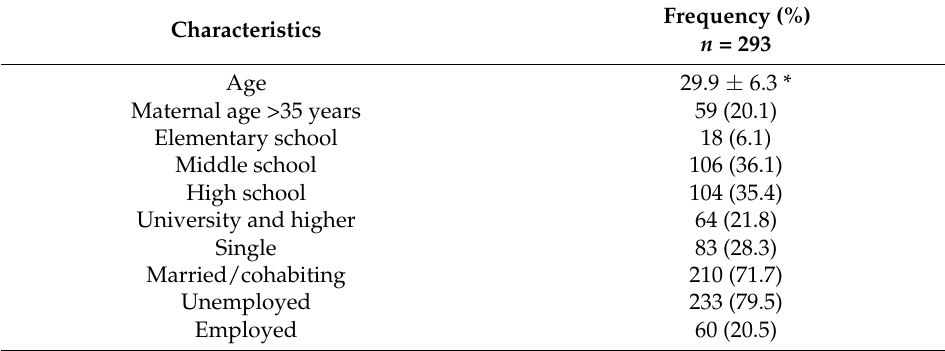
Table 1. Sociodemographic characteristics of the participants.